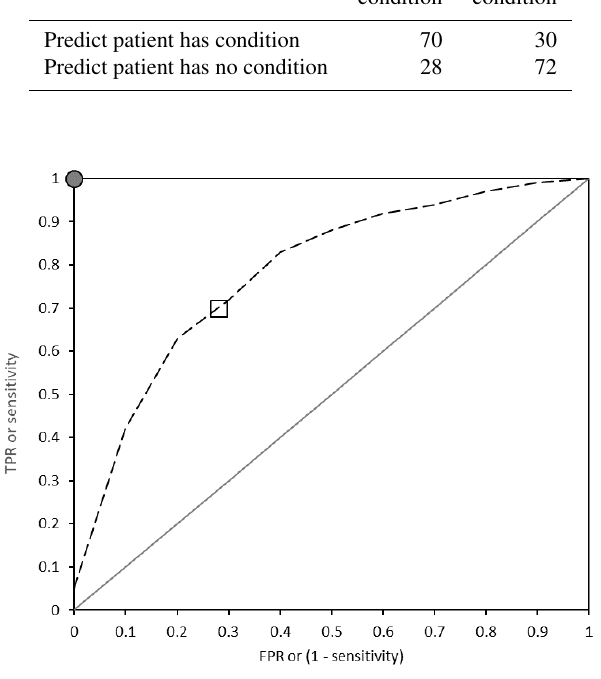
Figure A1. ROC space and plots of the prediction examples dis- cussed in the